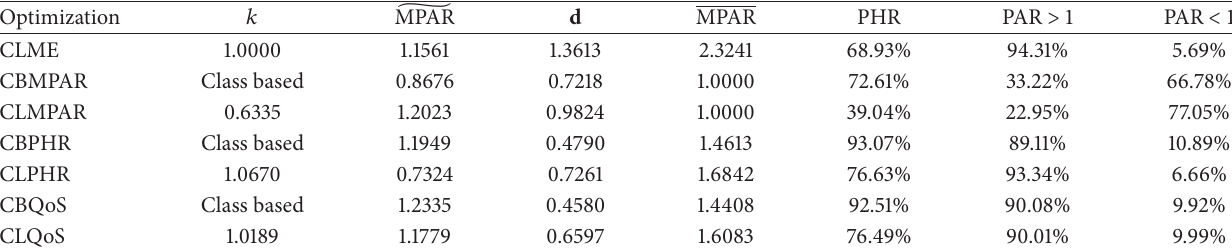
Table 6: Overview of